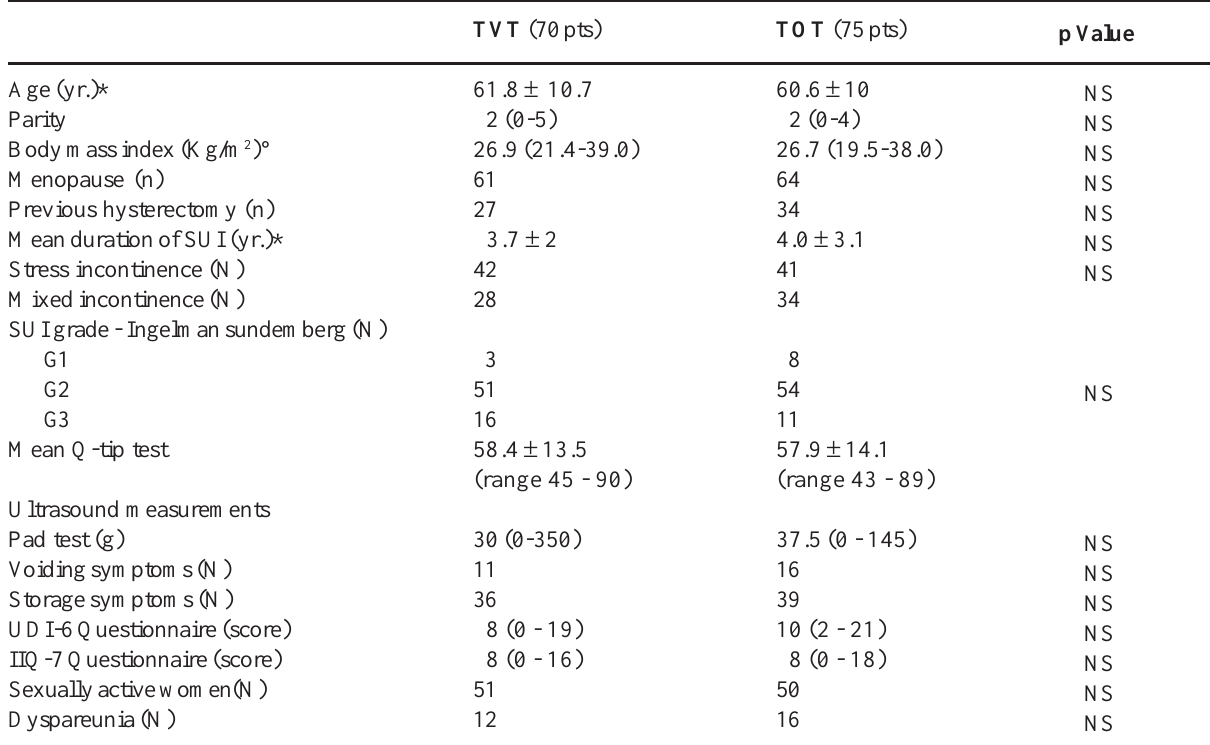
Table 1 – Preoperative characteristics of patients.